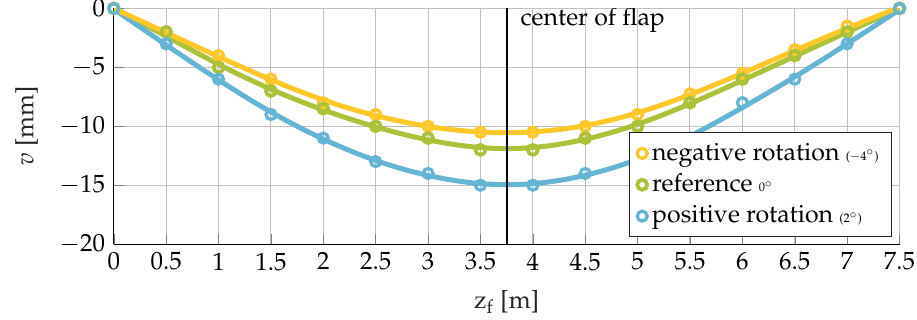
Figure 15. Deflection of the flap by a rotation around x-axis and compliant interfaces.